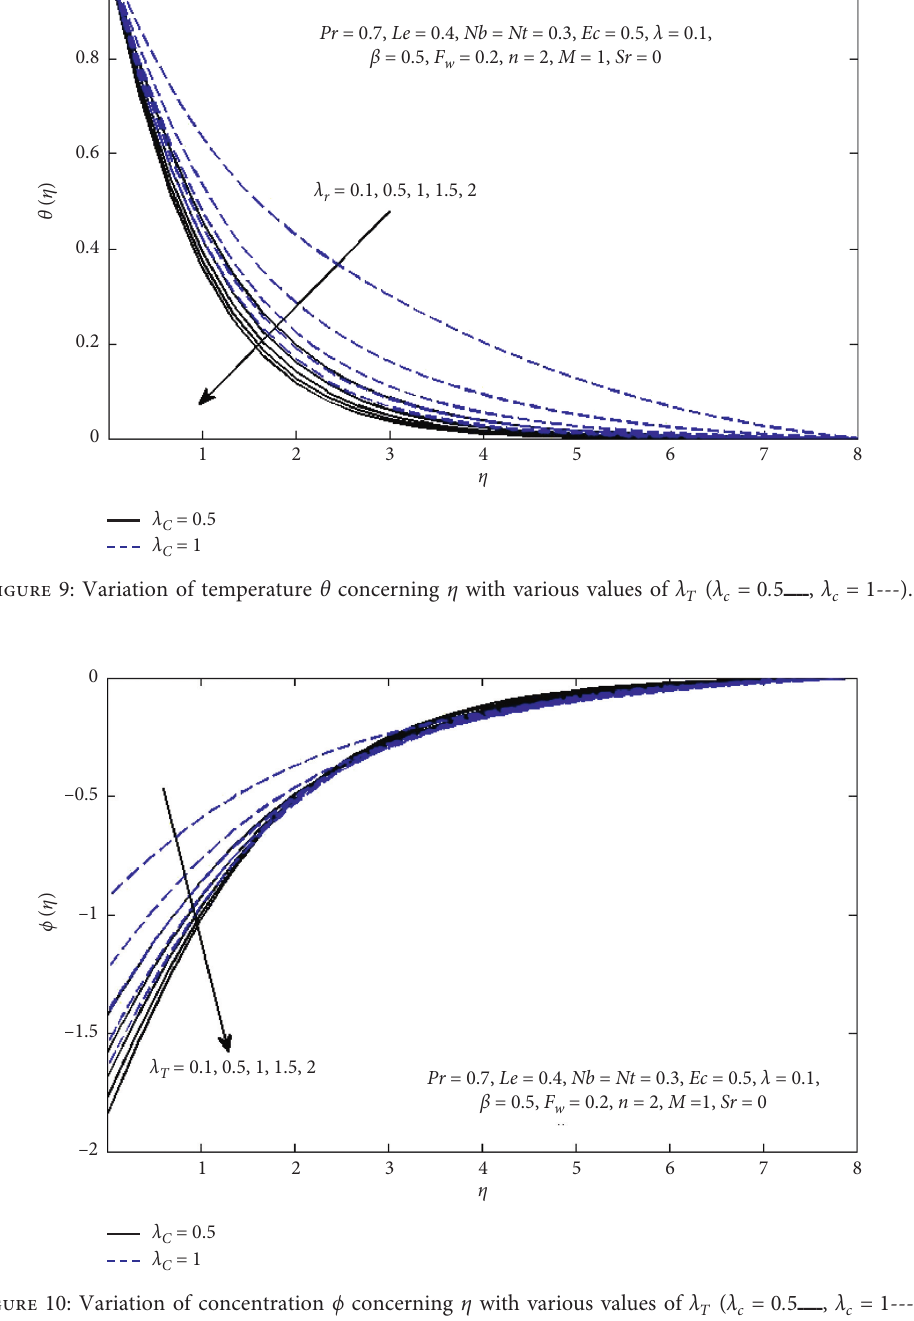
� 0 . 5 ــــ , λ � T ( λ c c